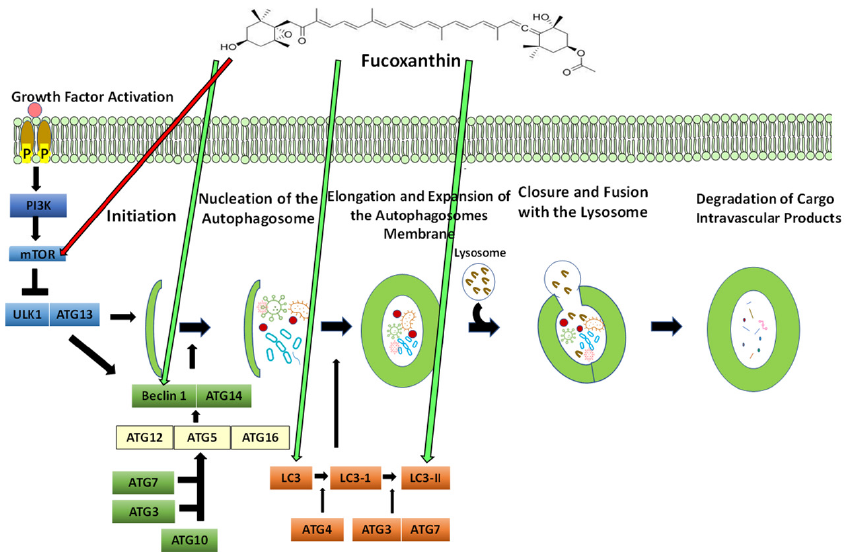
Figure 6. The proposed effect of fucoxanthin on autophagosome production. Red arrows indicate that inhibition is induced by fucoxanthin, and green arrows indicate activation is induced by fuco- xanthin.